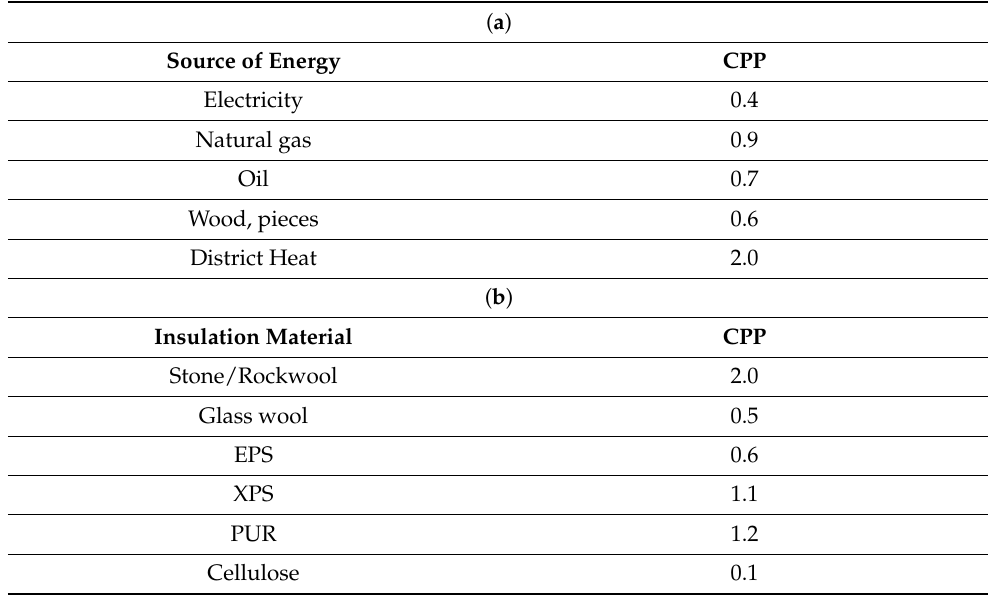
Table 12. ( a ) Average CPP values for different energy sources. ( b ) Average CPP values for various insulation materials.